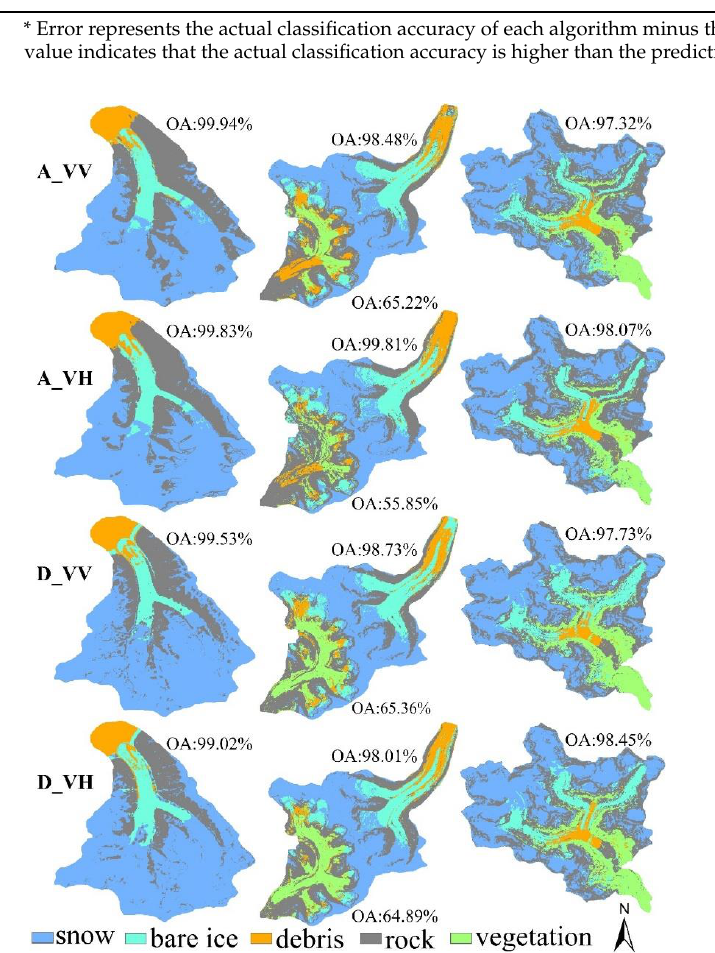
Figure 9. Classification results of the four glaciers from the four BC data suites (see Table 4). Each row corresponds to a BC suite of a specific orbit node and co/cross-polarization mode. Each column corresponds to a glacier or glaciers. The NE and SW glaciers are displayed in the middle column since they are close.